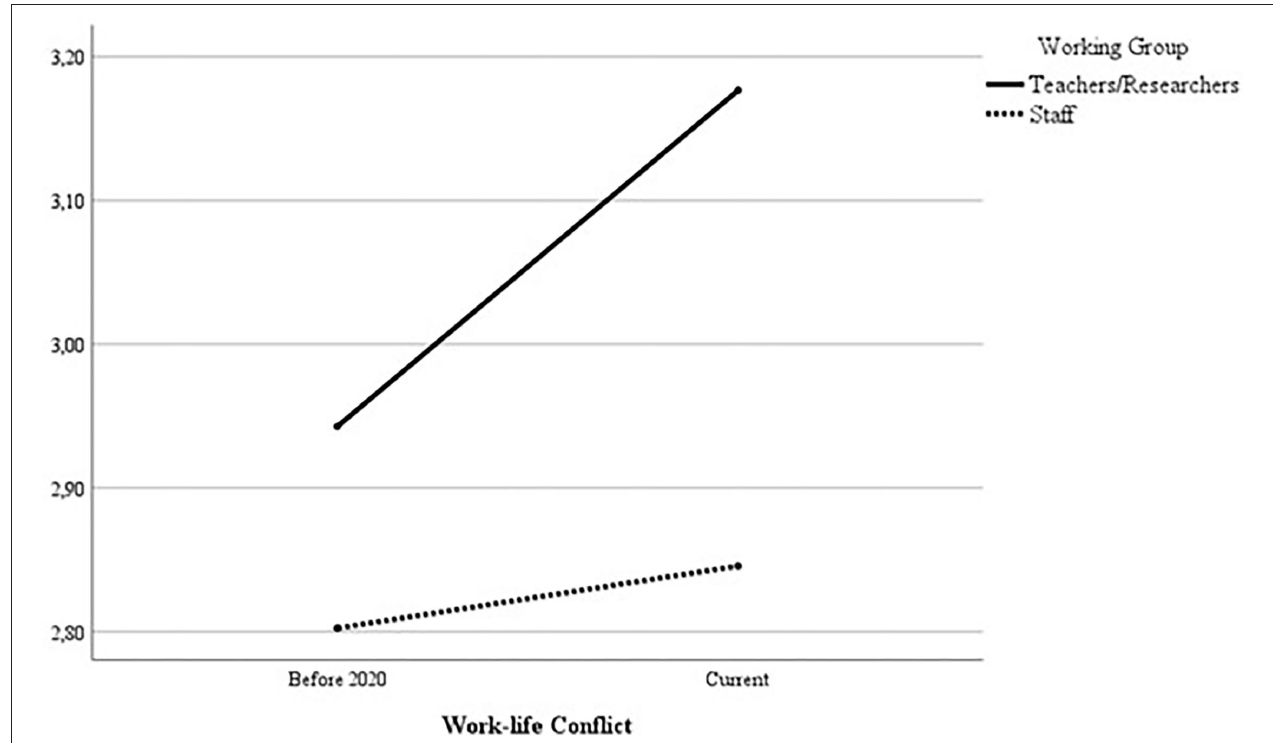
FIGURE 1 | WLC before and during the pandemic among teachers/researchers and staff.